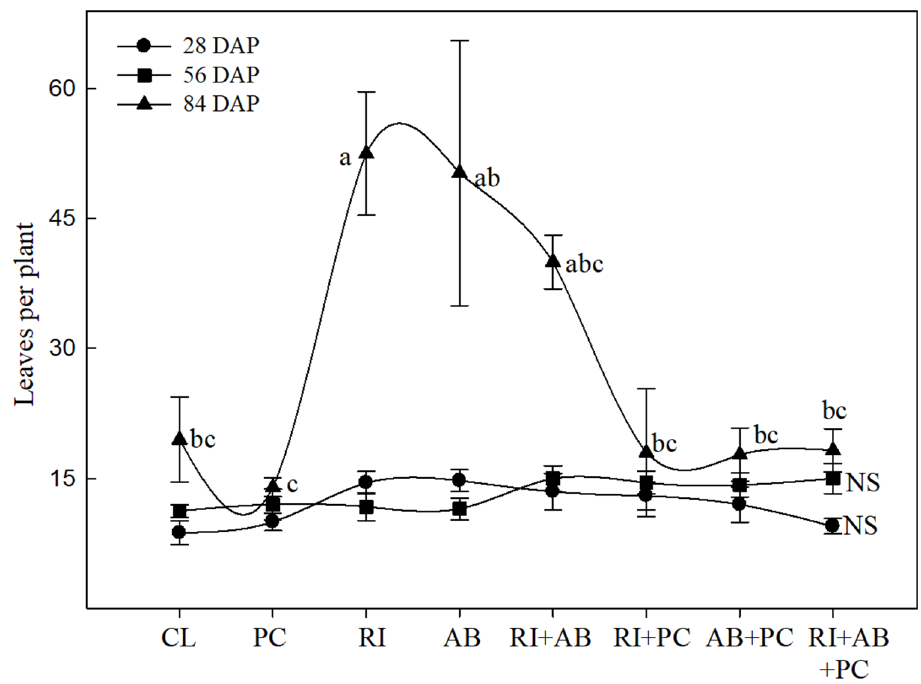
Figure 1. Number of leaves per plant of S. edule var. virens levis Costa Rica Type due to the effect of biofertilization with R. intraradices and/or A. brasilense in interaction with P. capsici . The vertical line indicates ± standard error. CV = 25% for 28 DAP, 21.9% for 56 DAP and 48.5% for 84 DAP. Different letters represent significant differences ( p < 0.05).